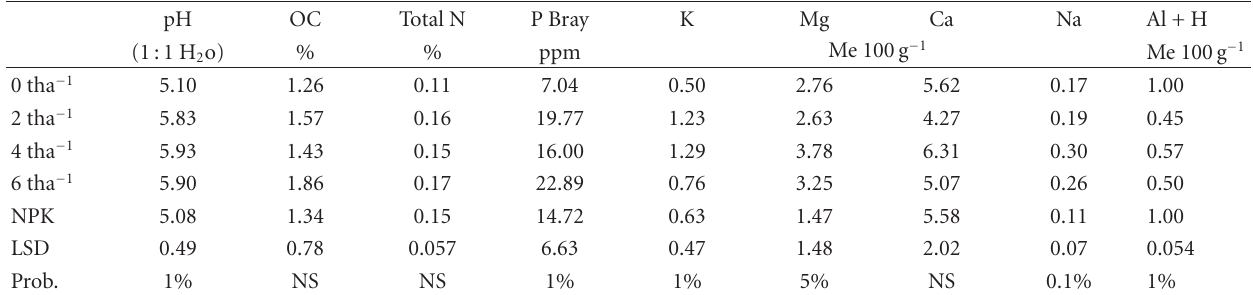
Table 3: Chemical properties of the 0–20 cm layer of the soil 110 days after application of the palm bunch ash and NPK for the major rainy season